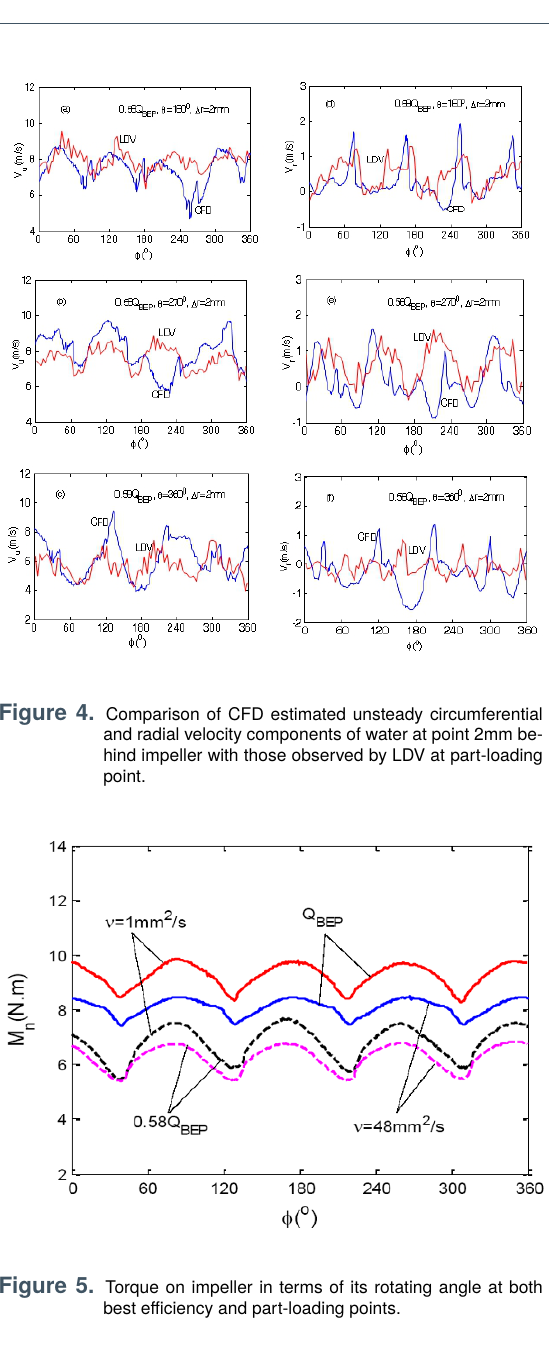
Figure 5 indicates the predicted total torque applying on the four blades, shroud and hub as a function of impeller rotating angle at the best efficiency and part-loading points for water and the viscous oil. It is clear that the torque shows a periodic pattern against the rotating